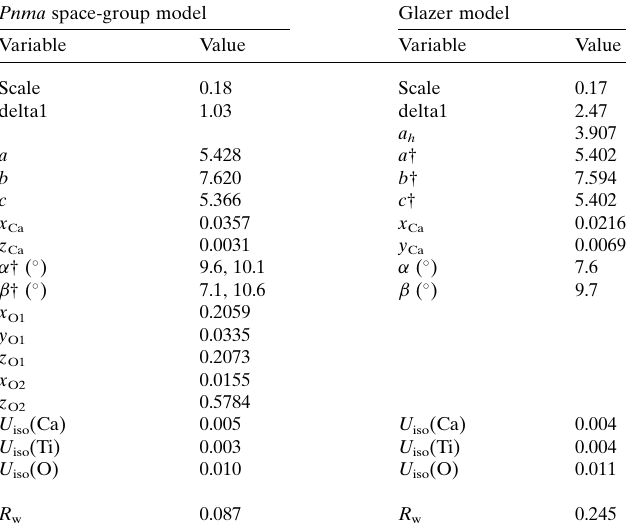
Table 2 Comparison of parameters from the space-group and Glazer model refinements over the r range 1.6–50 A˚ . Two values are given each for (cid:2) and (cid:3) in the space-group model because different octahedra tilt by different amounts. We note that the